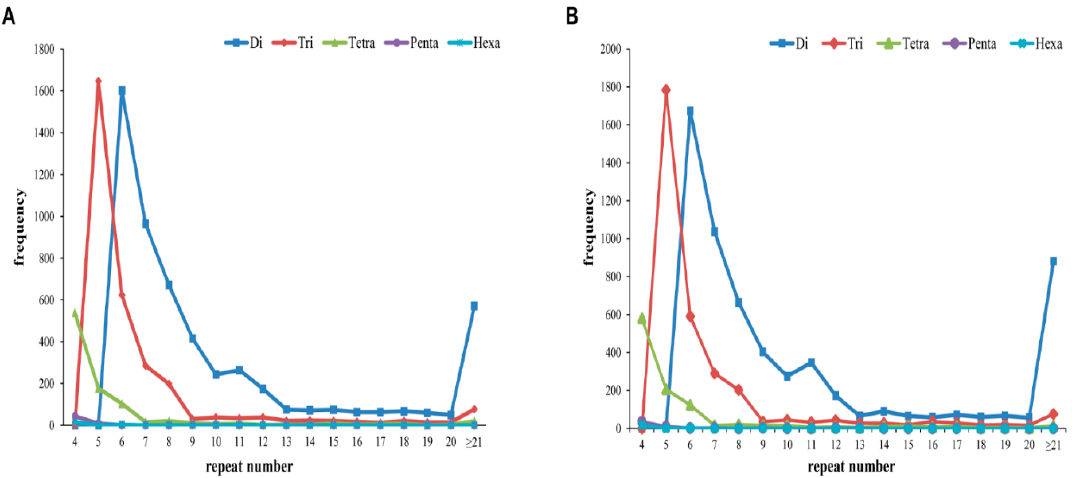
Figure 11. Summary of classified SSR repeat types in A. chejuensis ( A ); and A. quelpartensis ( B ) transcriptome.